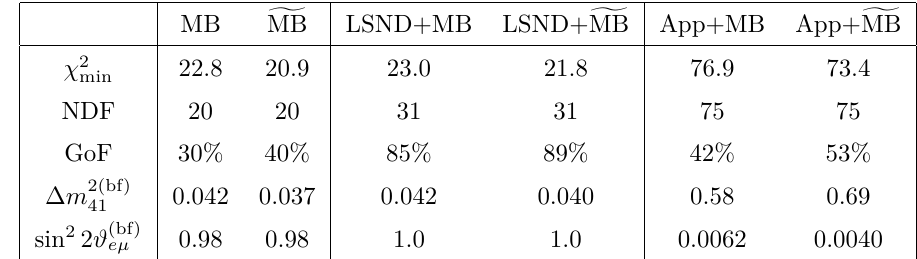
Table 2 . Minimum χ 2 , number of degrees of freedom (NDF) and Goodness of Fit (GoF) of the analyses of the data of short-baseline ( − ) ν µ → ( − ) ν e experiments discussed in the text without (MB) and with ( g MB) our enhanced single- γ background in MiniBooNE. ∆ m 2 (bf) best-fit values of the corresponding oscillation parameters.